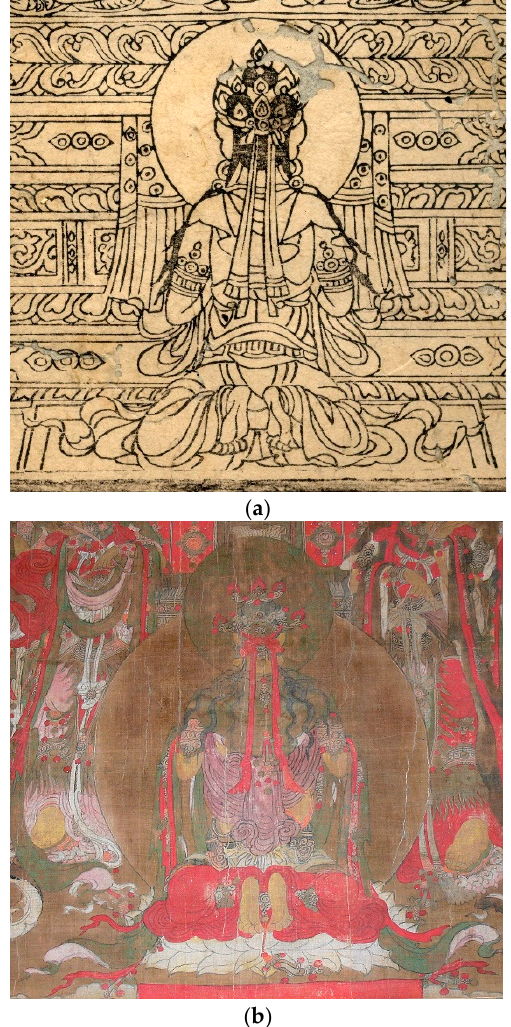
Figure 10. The Listener iconography from ( a ) the Lotus Sutra published by Gyeonseongam Hermitage; ( b ) 16th-century Sakyamuni Preaching. Arranged by the author.